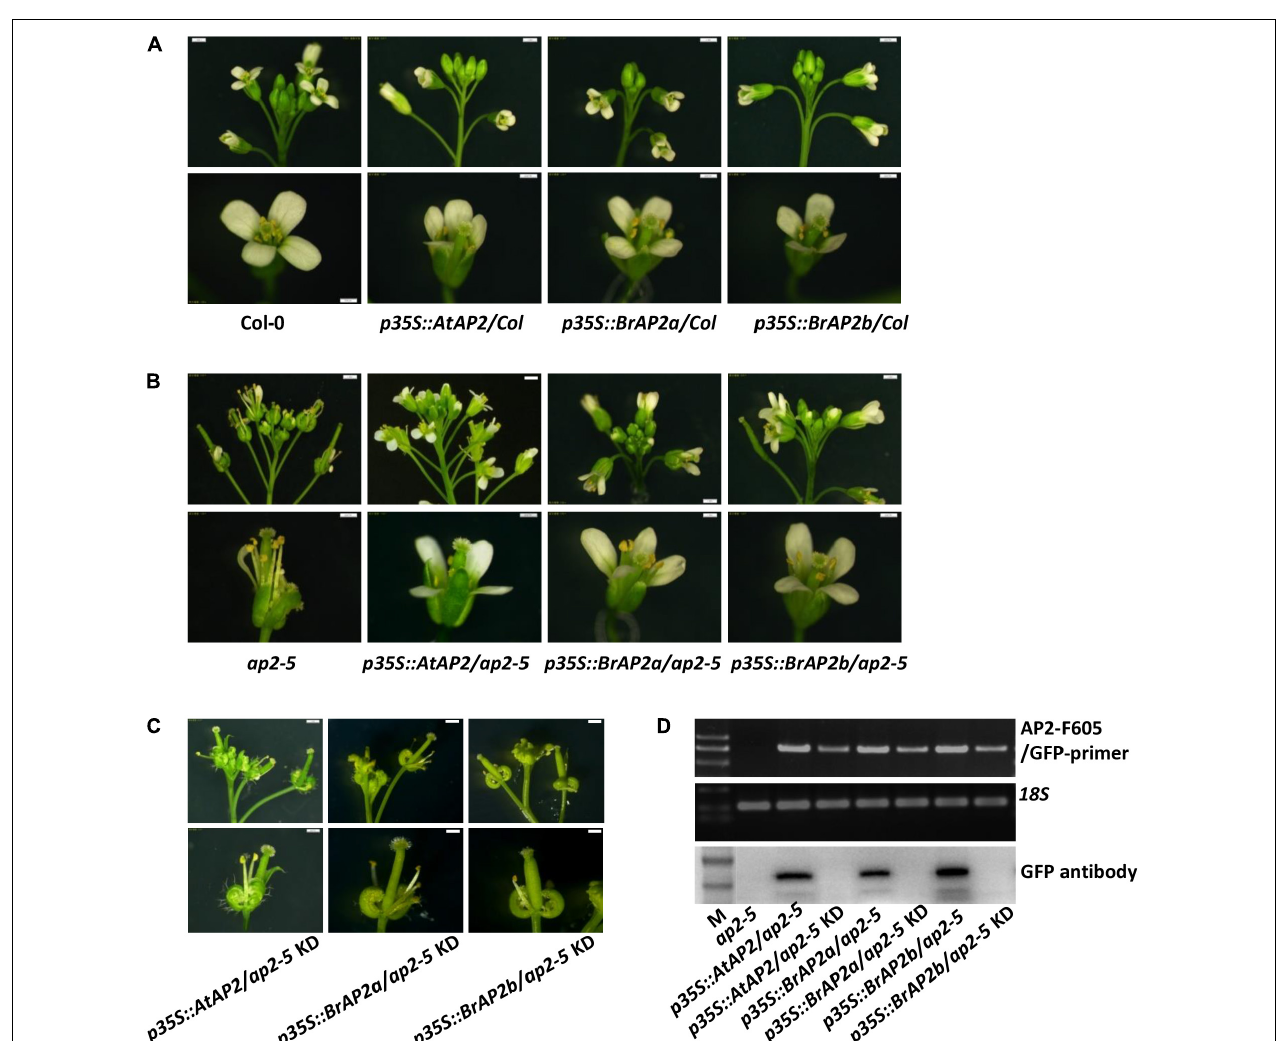
FIGURE 4 | Wild type and an ap2 weak mutant of Arabidopsis transformed with AP2 genes from B. rapa. (A) Wild-type Arabidopsis (Col-0) transformed with AtAP2 (control) and two AP2 genes of B. rapa . Their over-expressed lines p35S:AtAP2/Col , p35S::BrAP2a/Col , and p35S::BrAP2b/Col had normal flowers similar to the wild-type flower. (B) The AP2 mutant of Arabidopsis ( ap2-5 ), which has a mild sepal-to-carpel and petal-to-stamen phenotype, transformed with AtAP2 gene and two B. rapa AP2 genes. All three transgenic plants, p35S:AtAP2/ap2-5 , p35S::BrAP2a/ap2-5 , and p35S::BrAP2a/ap2-5 , rescued the ap2-5 mutant defect and developed normal sepals and petals. (C) The knockdown lines, p35S::AtAP2/ap2-5 KD , p35S::BrAP2a/ap2-5 KD, and p35S::BrAP2b/ap2-5 KD, from three transgenic group of p35S:AtAP2/ap2-5 , p35S::BrAP2a/ap2-5 , and p35S::BrAP2a/ap2-5 . (D) semi-quantitative RT-PCR and Western blot assays to validate the transgenic lines. Bars, 500 µ